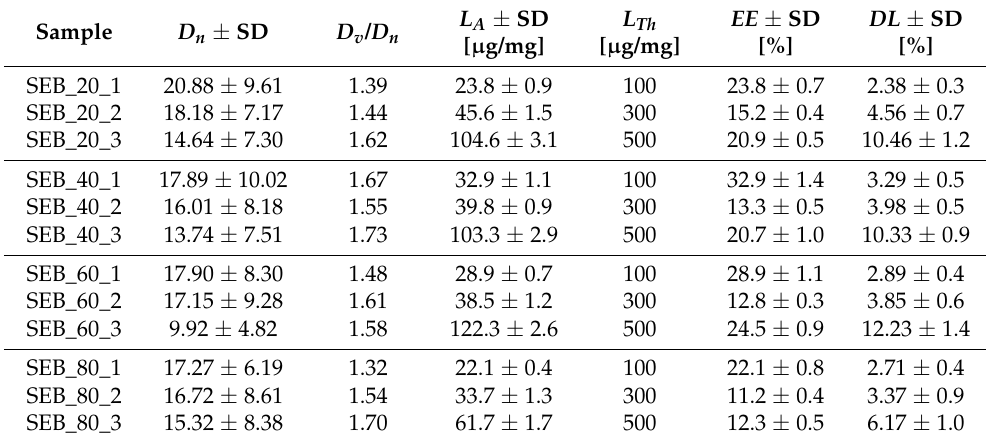
Table 6. Microsphere size, actual and theoretical loading, encapsulation efficiency and drug loading of large rifampicin-loaded microspheres.